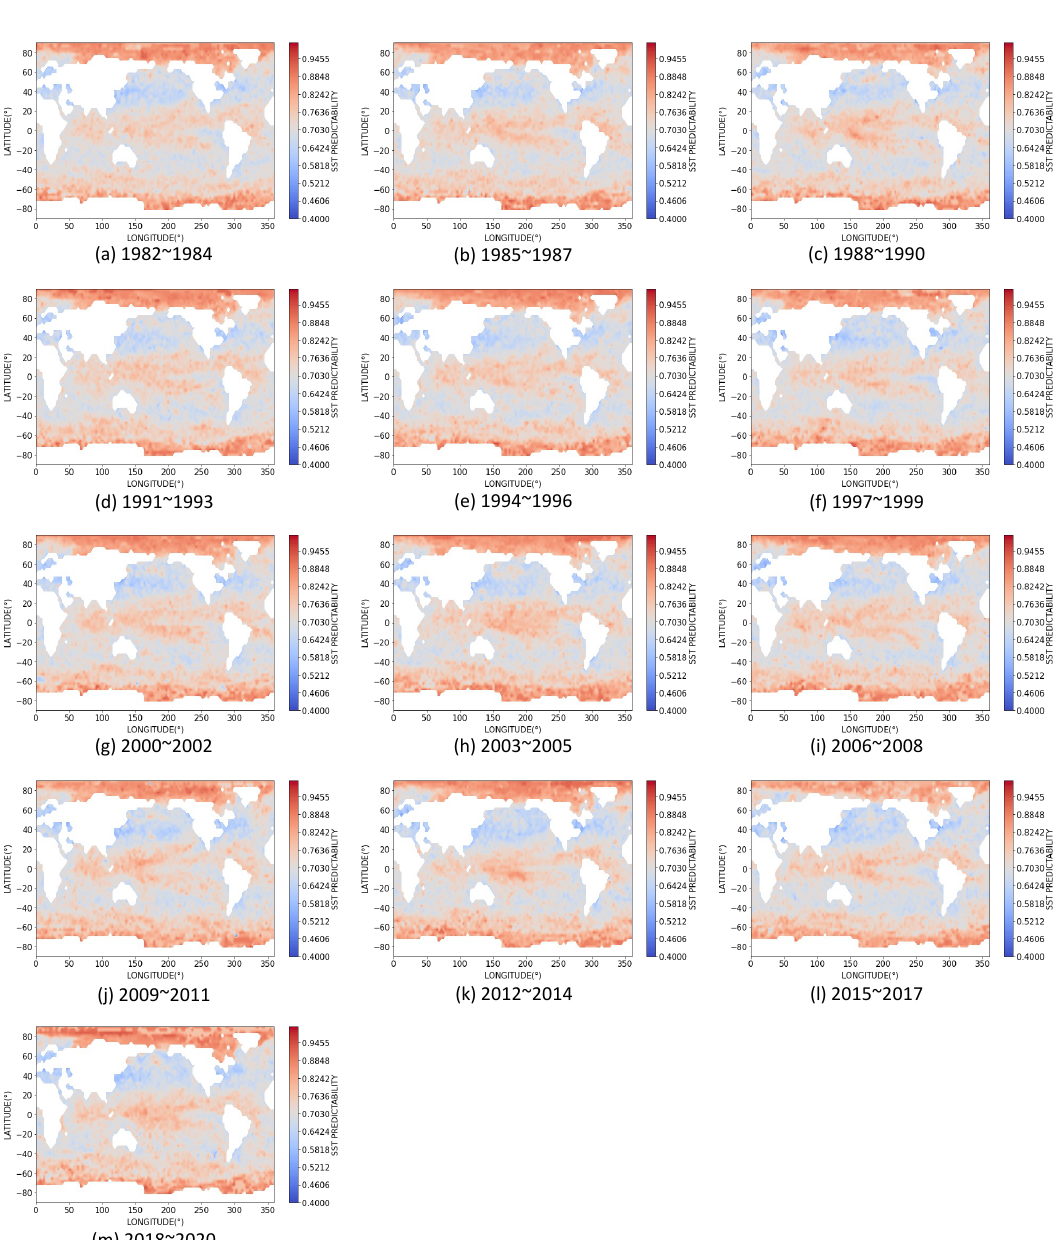
Figure 14. The predictability of SST around the world in 13 time periods from 1982 to